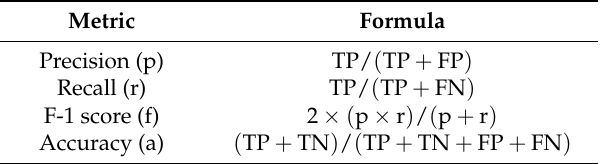
Table 4. Classification model performance